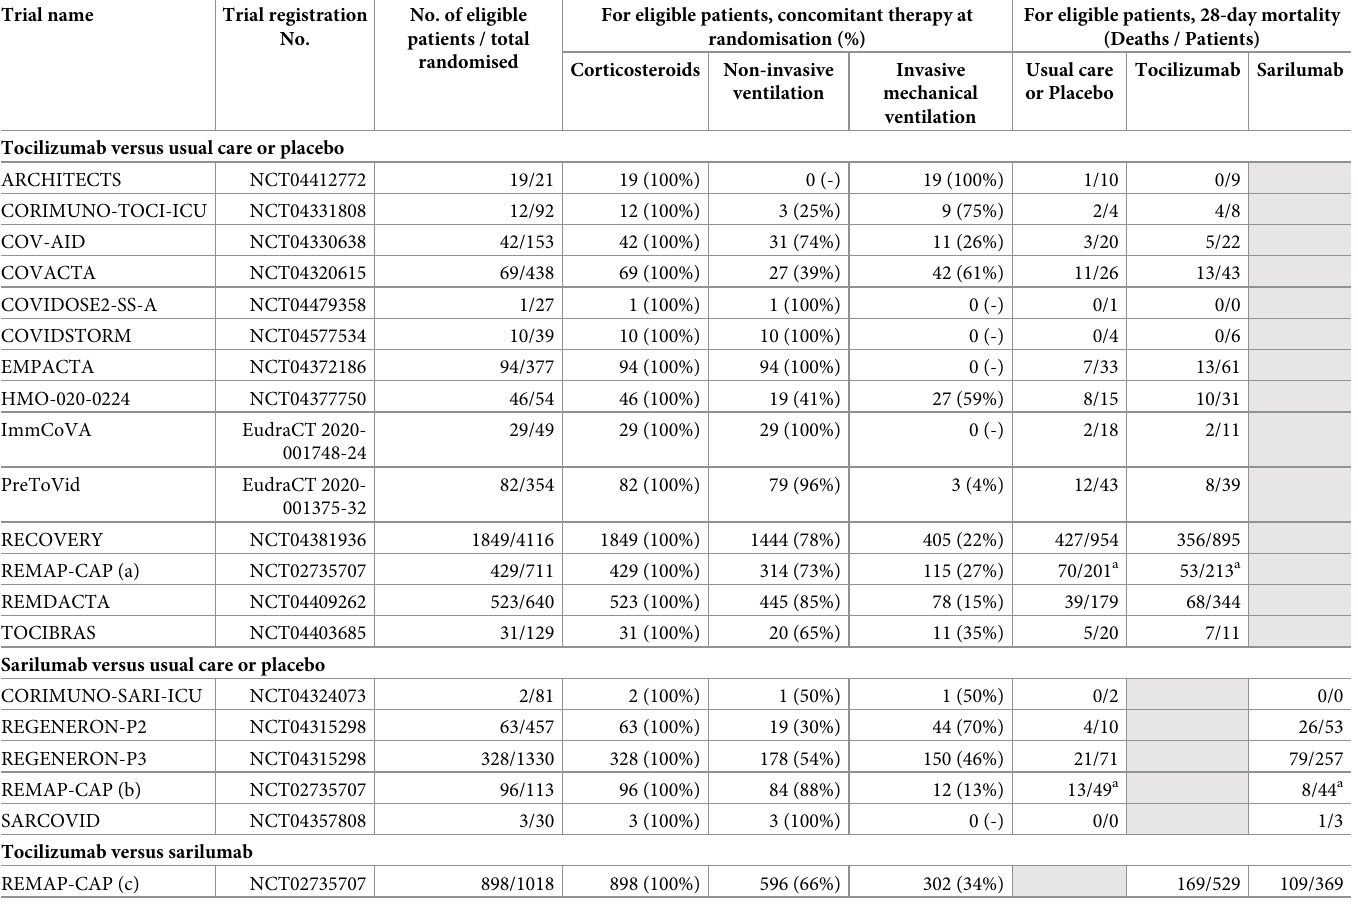
Table 1. Summary of included trials, patient characteristics and all-cause mortality 28 days after